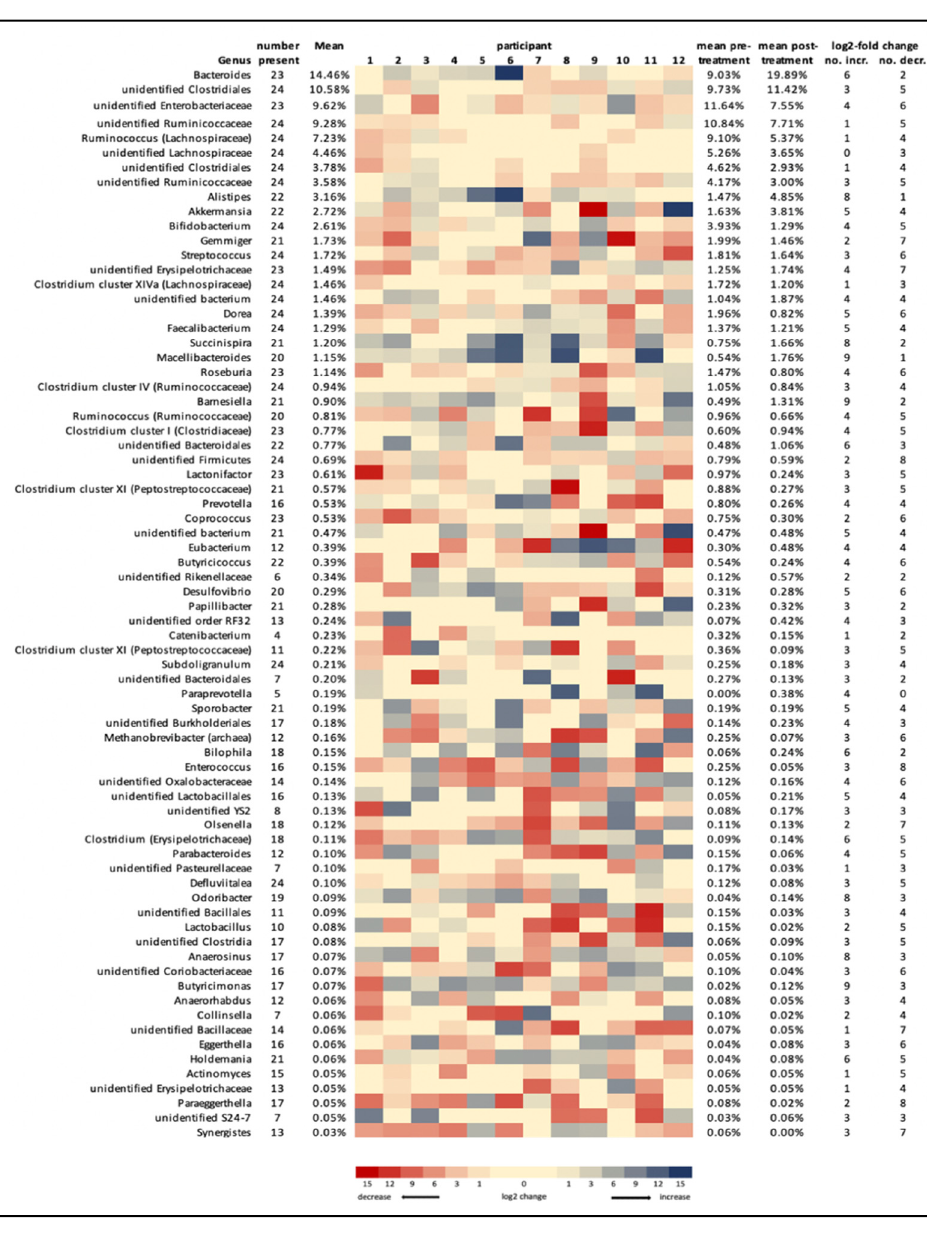
Figure 4. Heatmap of changes in relative abundance of genera for individual participants. Colours represent the change in relative abundance expressed as log2 fold change of post-treatment compared to pre-treatment.